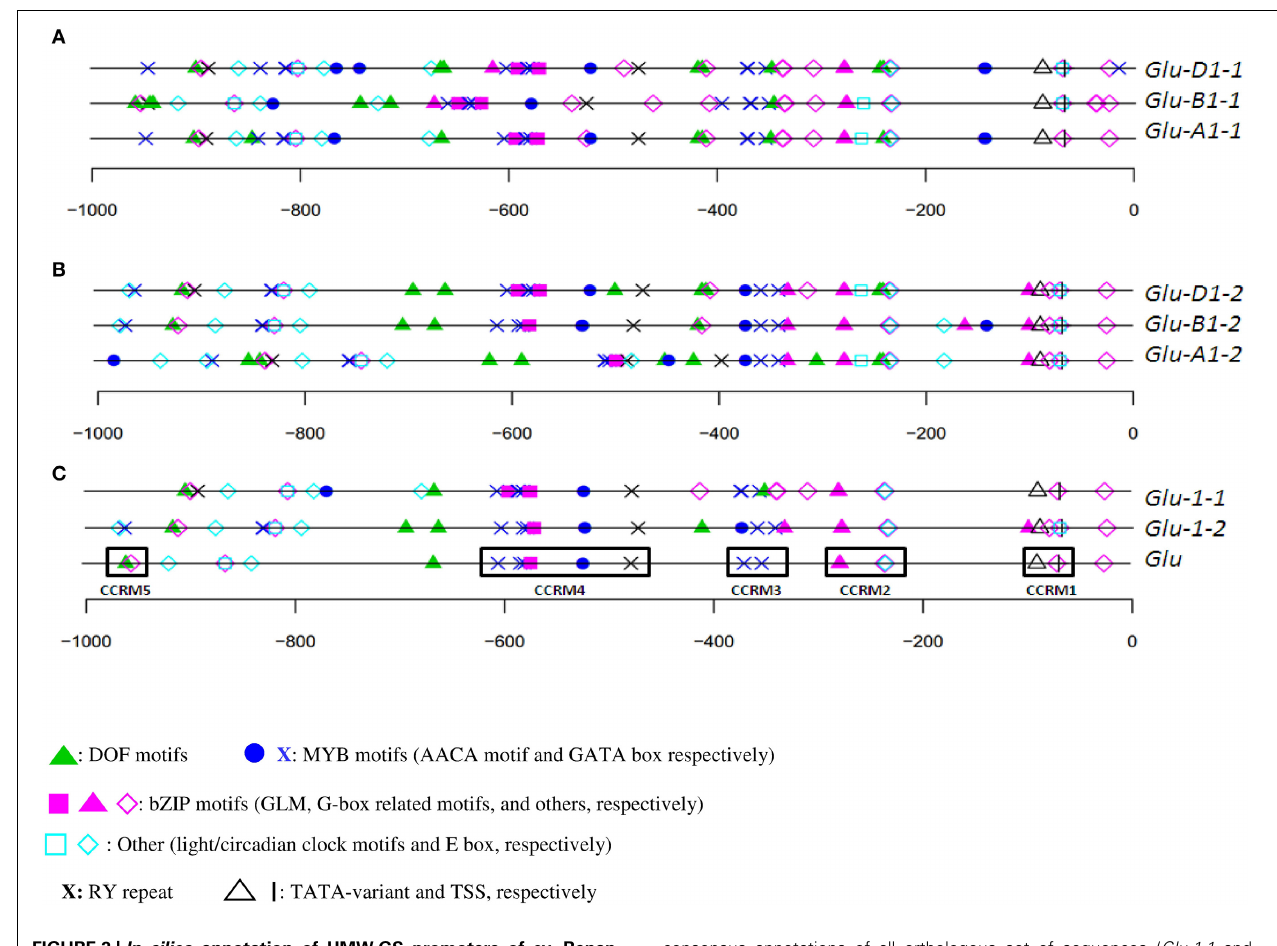
consensus annotations of all orthologous set of sequences ( Glu-1-1 and Glu-1-2 for the x- and y-type HMW-GS promoters, respectively), and of paralogous sequences ( Glu ) with its five conserved cis -regulatory modules CCRM1 to